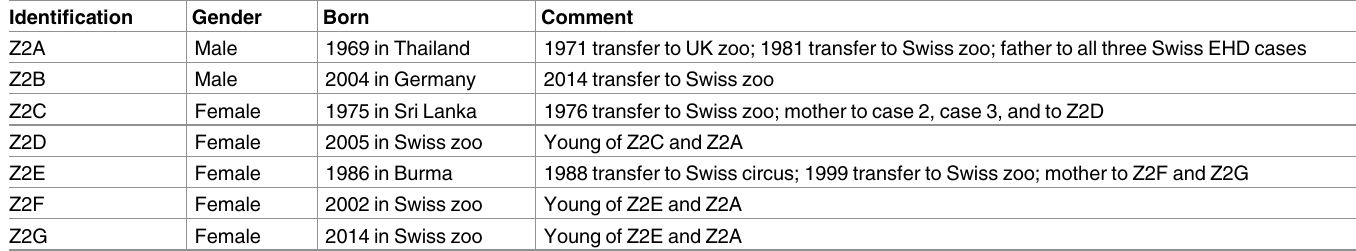
Table 1. Participating